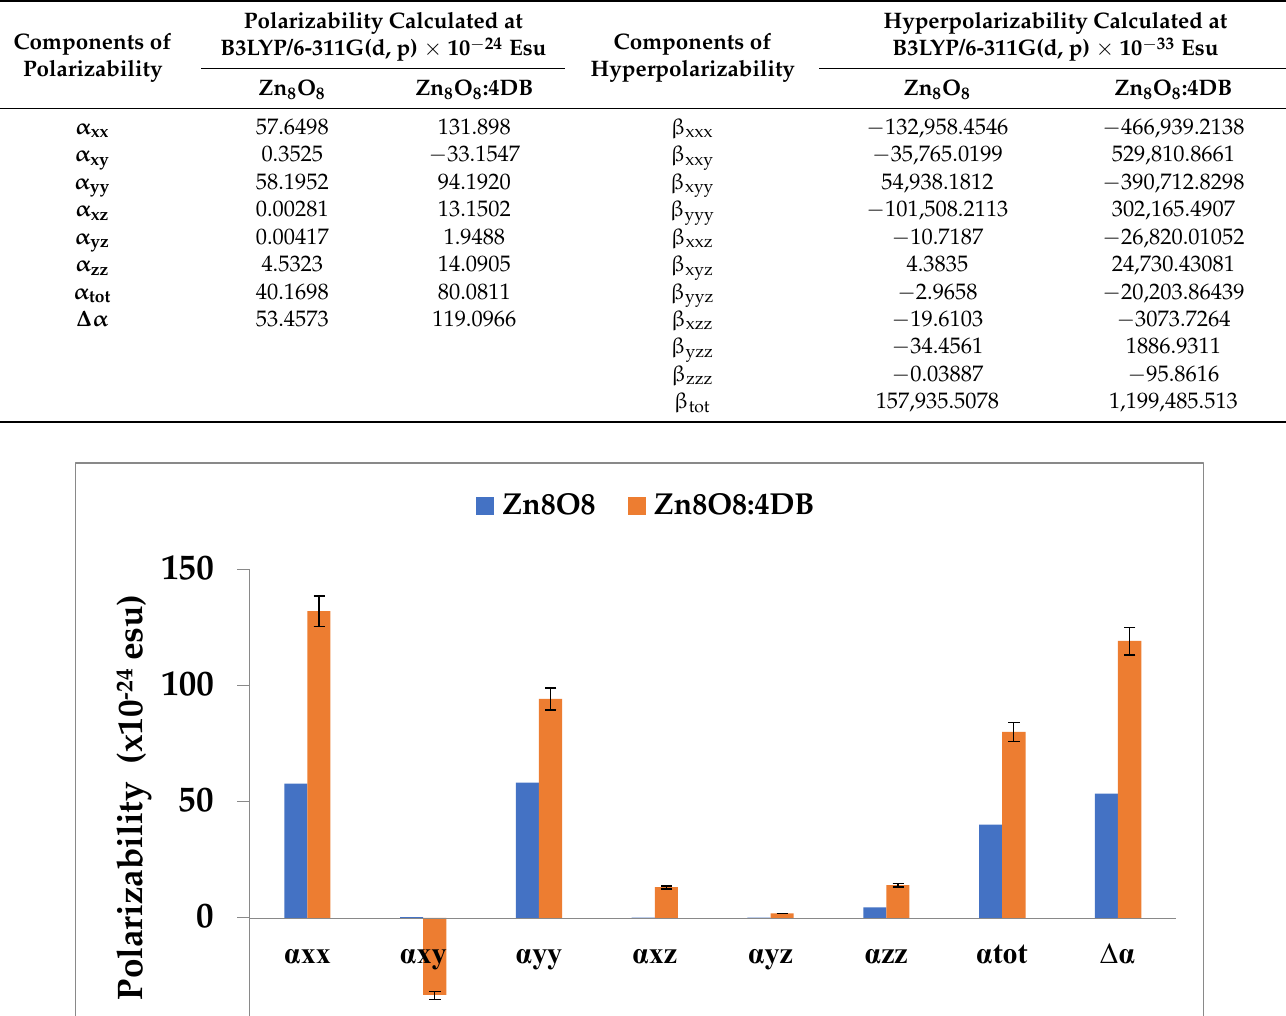
Table 4. Polarizability and first-order hyperpolarizability of the Zn8O8 and Zn8O8:4DB clusters calculated using B3LYP/6-311 G(d, p).